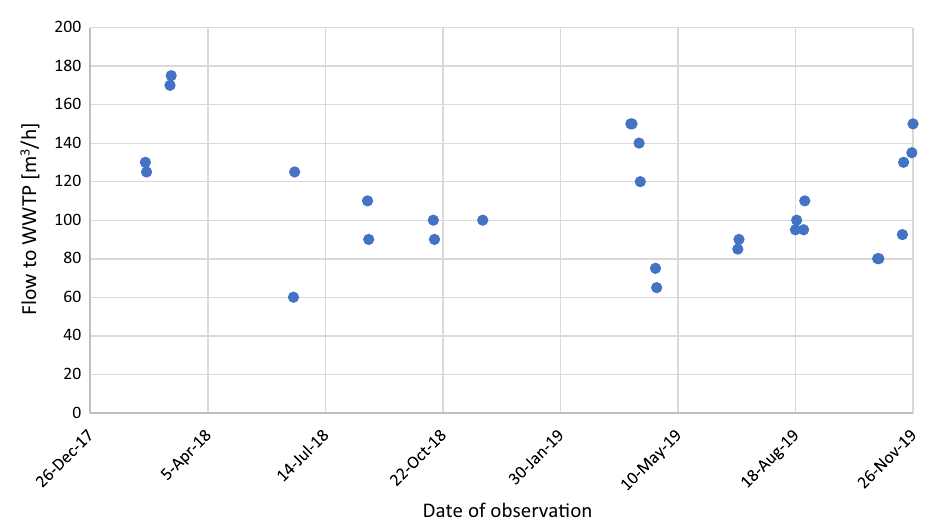
Fig. 1 Values and date of observed night